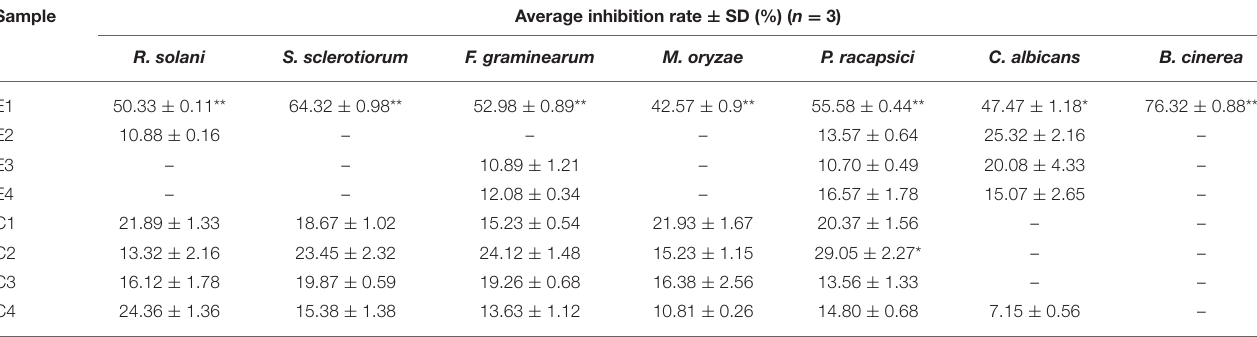
TABLE 4 | Antifungal activity of extracts and alkaloids from P. harmala L.